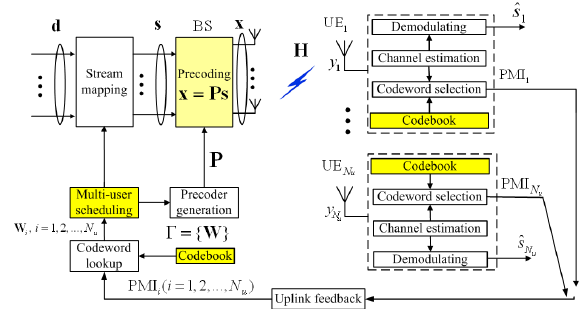
Figure 1. The feedback precoding model of the multi-user MIMO